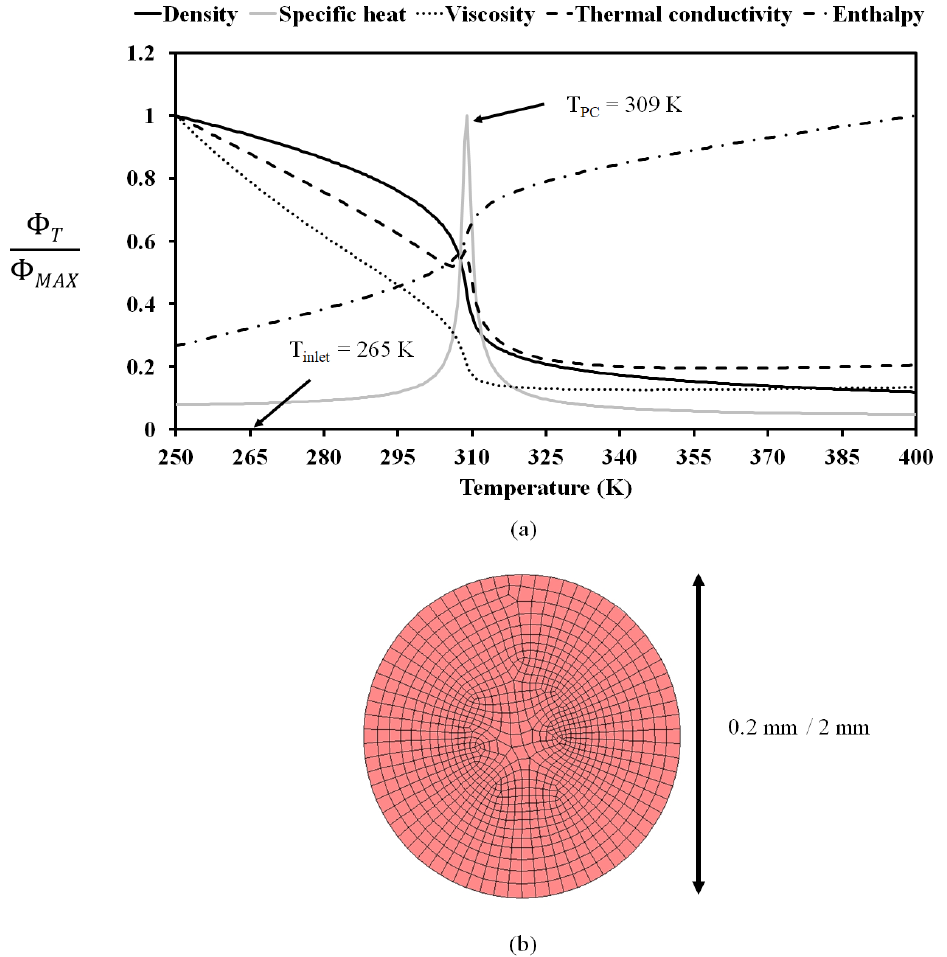
Figure 1. ( a ) Thermophysical properties ( Φ T ) of CO 2 at 8.2 MPa, normalized by their maximum values ( Φ MAX ) across the temperature range of interest 250–400 K); ( b ) the highly resolved mesh along the radial direction (in the 0.2 mm/2 mm diameter tubes).